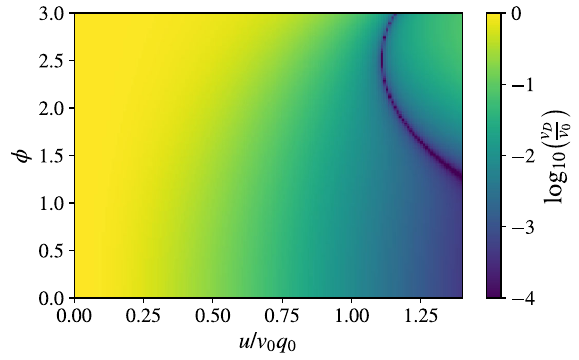
FIG. 6. Dirac velocity for the Dirac cone of the Hamiltonian Eq. (45) as a function of the parameters u; ϕ , in logarithmic scale. The Dirac velocity vanishes exactly on the dark line, leading to an exact flattening of the